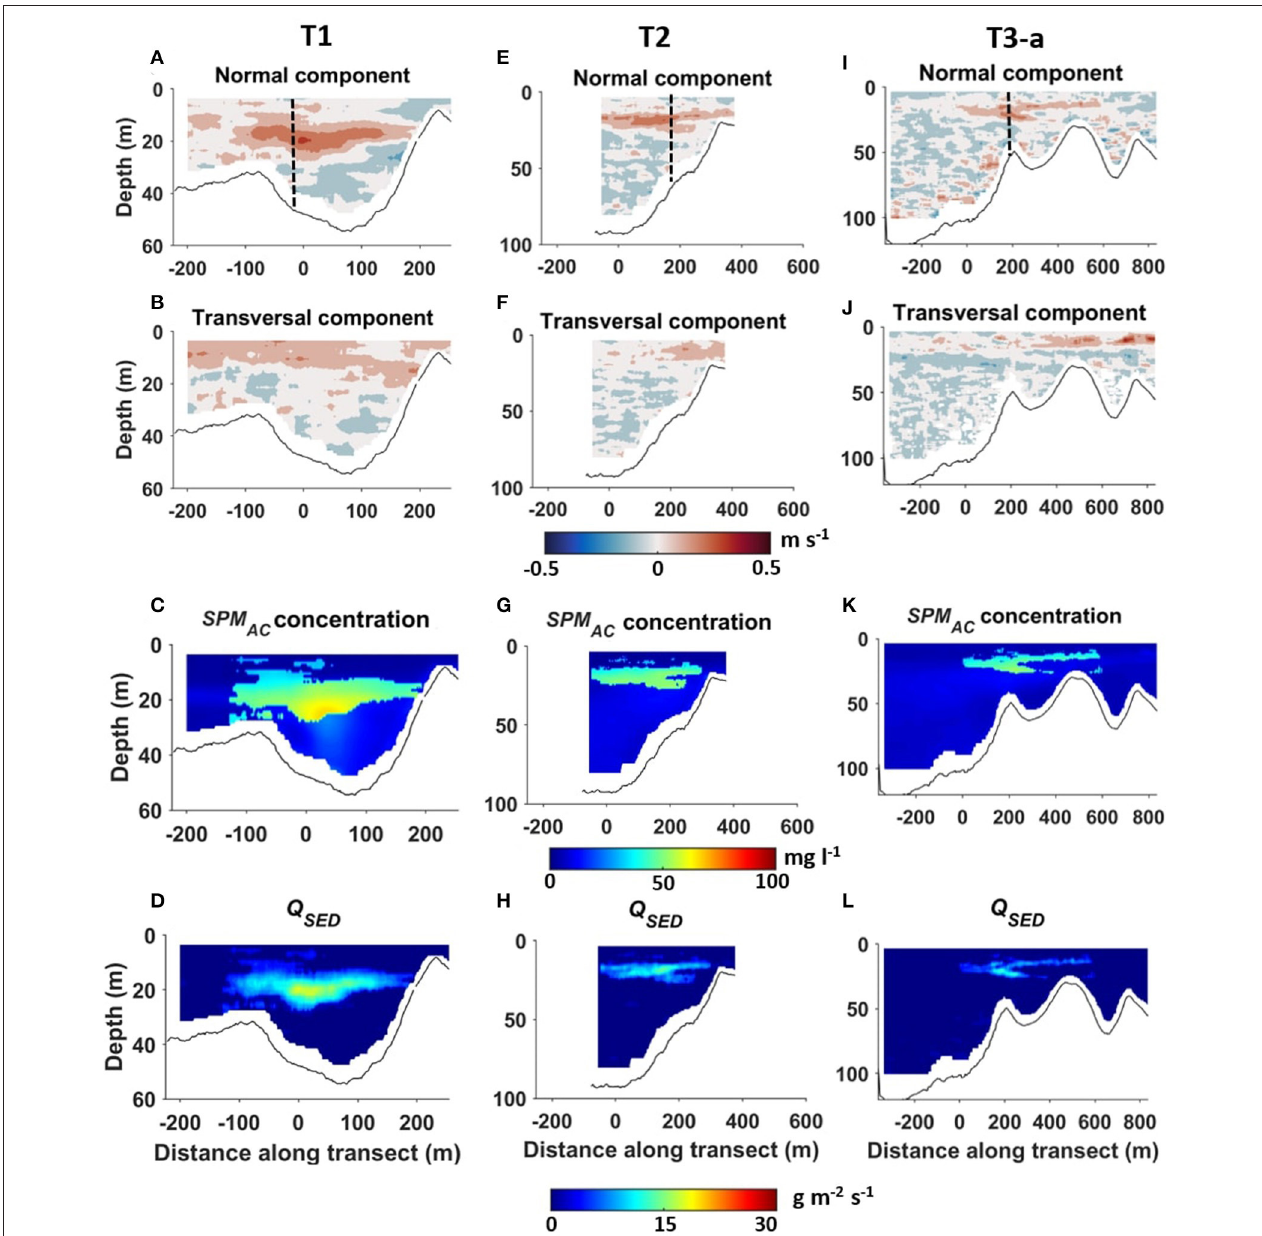
FIGURE 5 | (A,E,I) Normal and (B,F,J) transversal velocity components, (C,G,K) SPM AC concentrations, and (D,H,L) suspended sediment discharge Q SED , for transects T1, T2 and T3-b on 18 September 2018. Refer to Figure 1B for transect locations. The dashed lines correspond to the positions of stations P1, P2 and P3-b. Colorbars give parameter